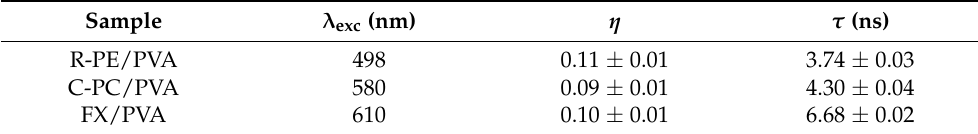
Table 1. Absolute emission quantum yield ( η ) for the indicated excitation wavelengths ( λ exc ) and emission lifetime values ( τ ), calculated from the best fit of the decay curves shown in Figures S9–S11 in Supplementary